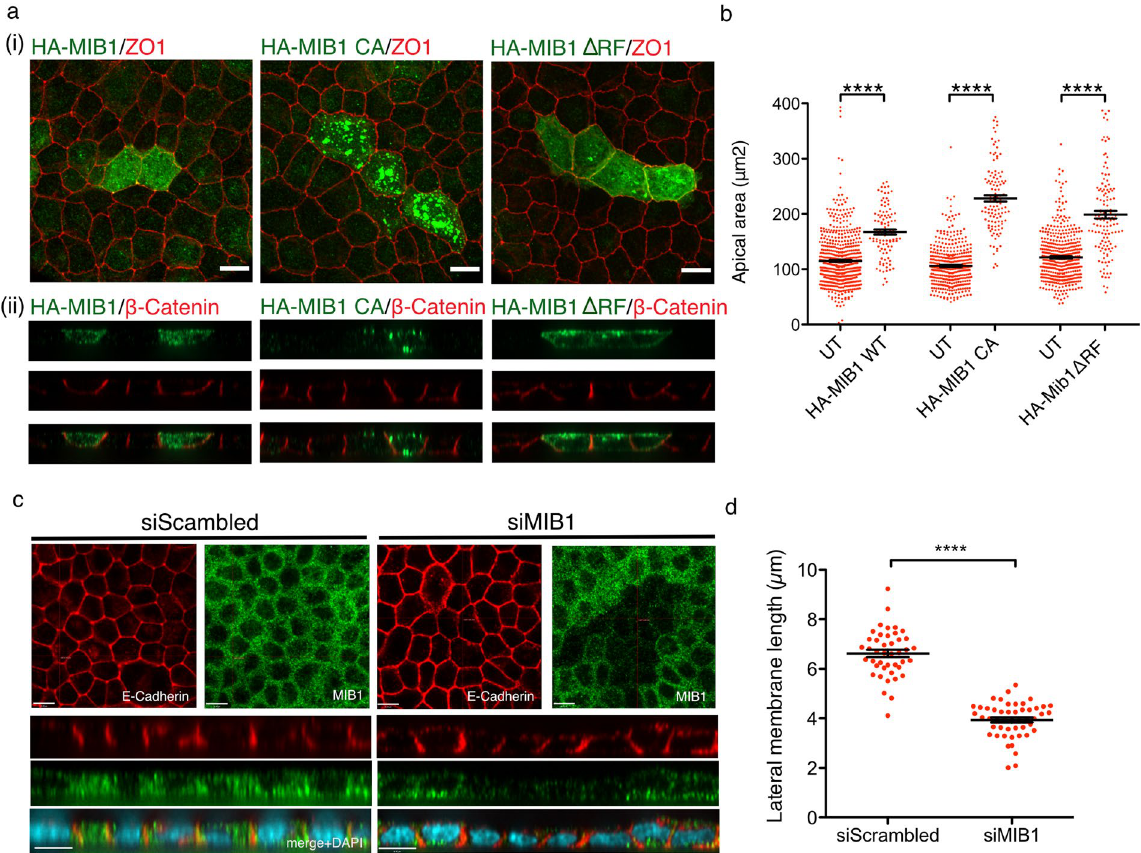
Figure 9. MIB1 expression in polarized MDCK cells regulates cell shape. ( a , b ) Overexpression of MIB1 results in the expansion of the apical membrane. MDCK cells were transfected with HA-MIB1, or the ubiquitin ligase mutants HA-MIB1CA or HA-MIB1 Δ RF. Polarized cells were fixed and stained with anti-HA (MIB1-transfected cells) and either (i)anti- ZO1 to delineate the apical region or (ii) β -Catenin to show the lateral membrane. (i) XY extended focus projections of transfected cells co-stained for MIB1 and ZO1. (ii) XZ optical sections of transfected cells co-stained for MIB1 and β -catenin. Images were acquired at 60X magnification on a Quorum spinning disk microscope. Scale bar indicates 10 μ m. ( b ) Quantification of the apical areas of polarized MDCK cells over expressing HA-MIB1 and adjacent cells. ZO1 staining was used to define the apical region and the area was measured using Volocity software. The individual cell measurements for 3 independent experiments are shown (HA-MIB1: 101 cells, adjacent untransfected: 601 cells; HA-MIB1CA: 112 cells, adjacent untransfected: 413 cells; HA-MIB Δ RF1: 127 cells, adjacent untransfected: 477 cells) together with the corresponding mean value + / − SEM. Differences in area between transfected cells and corresponding adjacent cells were tested for statistical significance using a 2-tailed Mann Whitney test, p = < 0.0001. ( c , d ) Depletion of MIB1 causes the shortening of the lateral membrane in MDCK cells. ( c ) MDCK cells treated with either scrambled or MIB1 siRNAs were allowed to polarize, then fixed and stained with anti-E-Cadherin (a marker of the lateral membrane) and anti-MIB1, and counterstained with DAPI to visualize nuclei. Shown are XY optical sections taken across the middle of the cell monolayer and XZ sections taken where the crosshair is positioned (top and bottom of each panel, respectively). Images were acquired at 60X magnification on a Quorum spinning disk microscope. Scale bars indicate 10 µ m. ( d ) Quantification of the effect of MIB1 depletion on lateral membrane height. Measurement of the lateral membrane length was performed using E-Cadherin stained samples and Volocity measurement software. The individual cell measurements for 2 independent experiments are shown (siScrambled: 43 cells, siMIB1: 49 cells) with the corresponding mean value + / − SEM. Statistical significance was tested using the 2-tailed Mann-Whitney test, p = <